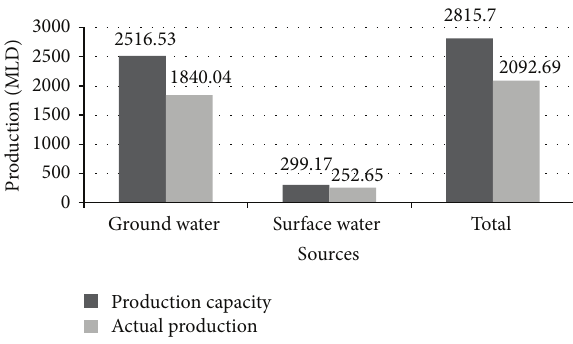
Figure 2: Water production per day in Dhaka city